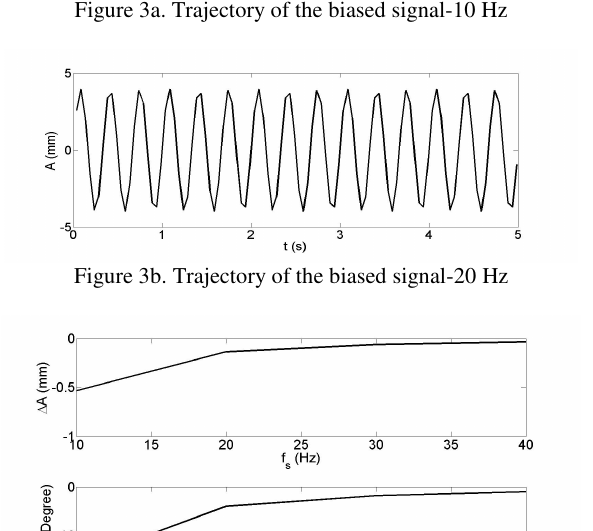
Figure 3a. Trajectory of the biased signal-10 Hz